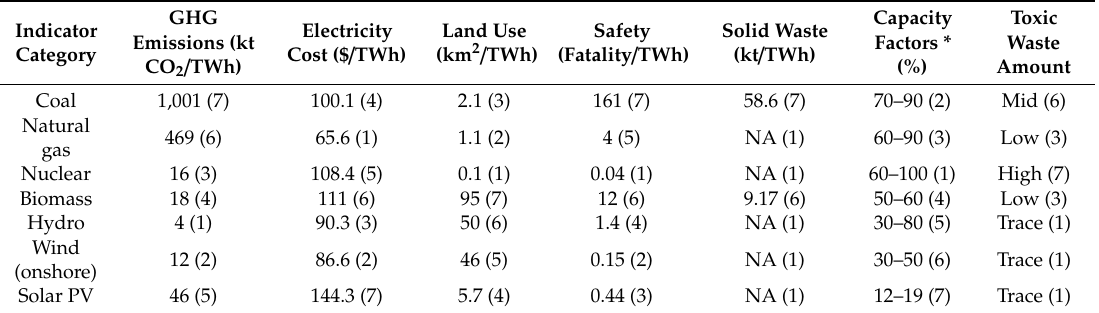
Table 1. Relative ranking of the power generation options, data adapted from Brook and Bradshaw [12]. The values in brackets are the relative ranking between energy